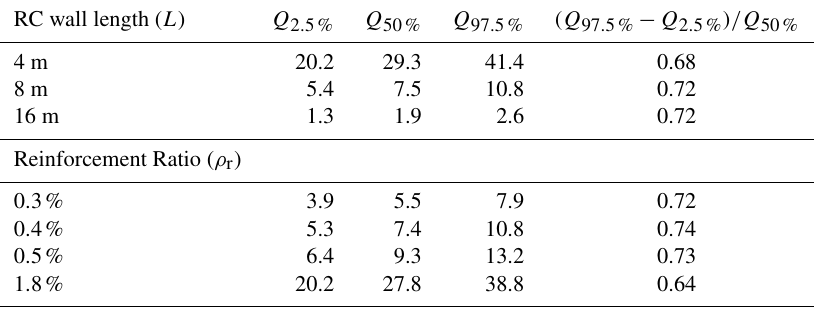
Table 5. The 2.5%, 50%, 97.5% quantiles (in kPa), and the fragility range ratio (Q 97 . 5% − Q 2 . 5% )/Q 50% of the fragility curves according to the length and reinforcement